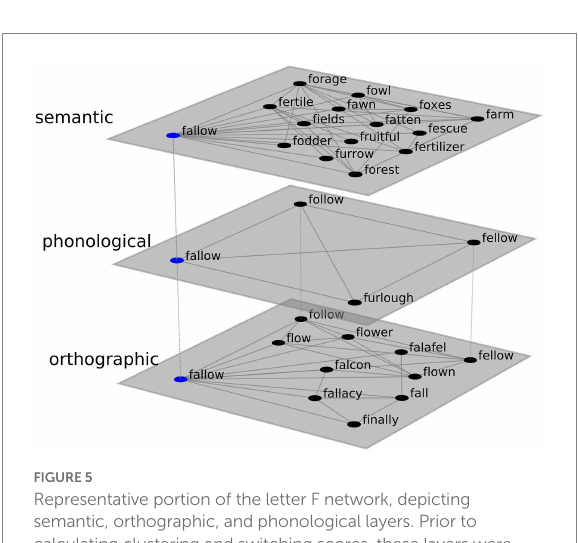
FIGURE 5 Representative portion of the letter F network, depicting semantic, orthographic, and phonological layers. Prior to calculating clustering and switching scores, these layers were collapsed into a single network by taking the union of edges.